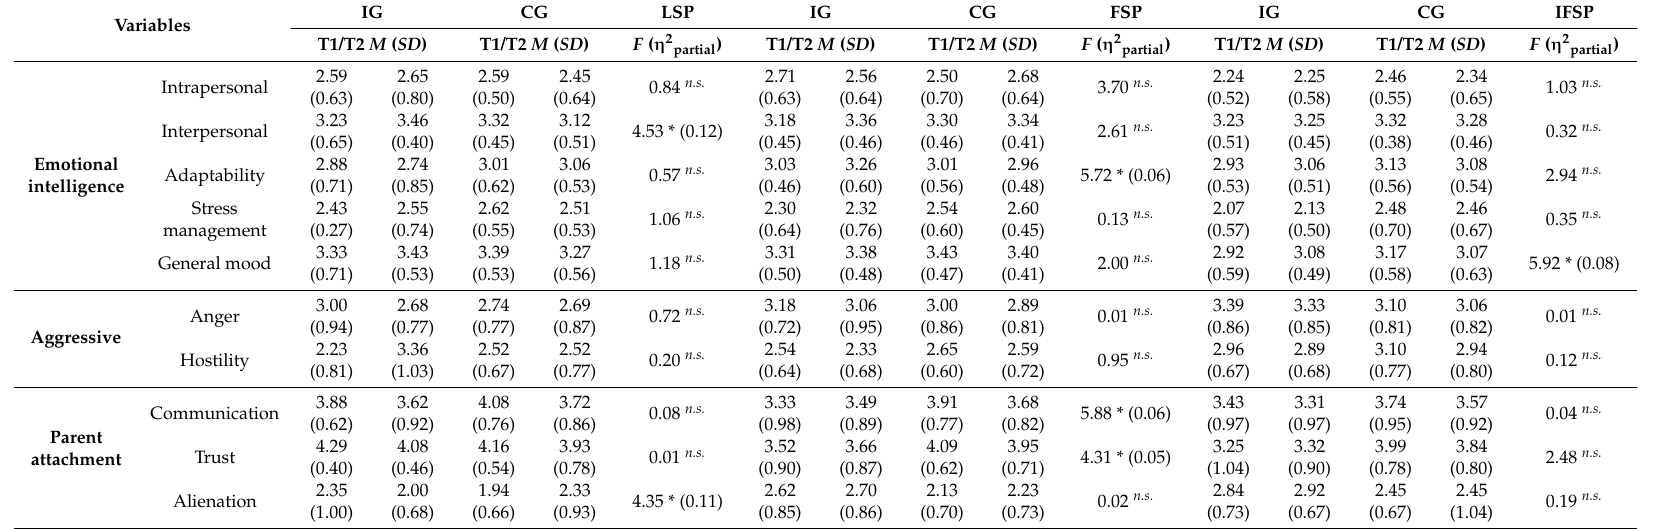
Table 3. Scene-Based Psychodramatic Family Therapy (SB-PFT) Effectiveness by Stress